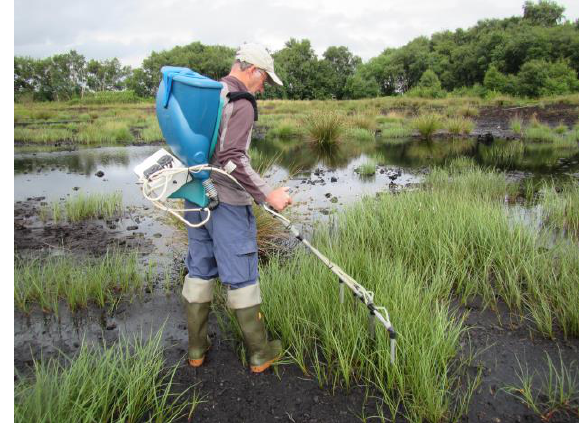
Figure 11. Sphagnum application to peat surface in ‘nurse’ vegetation using a backpack ‘blobbing’ machine at Cadishead (Lancashire Wildlife Trust).